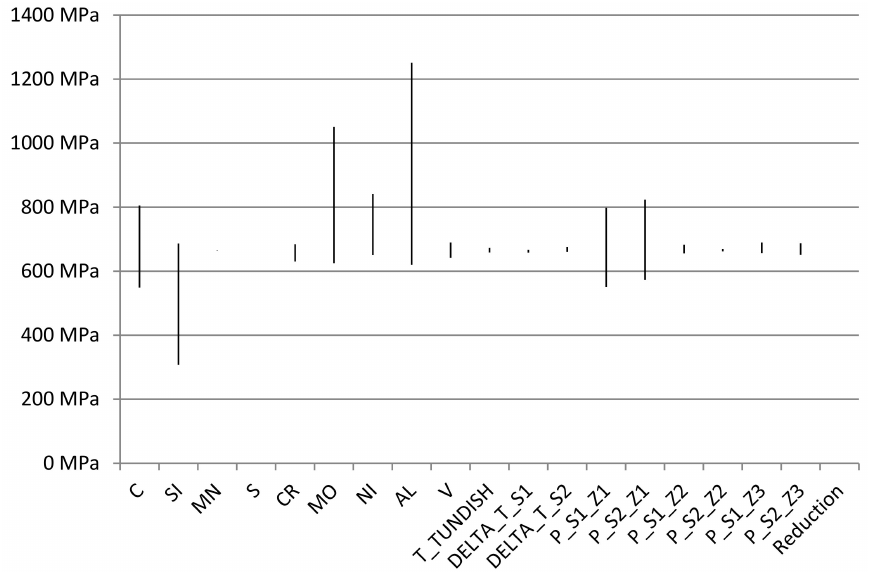
Figure 2. Calculated influences of individual parameters on tensile strength using the Genetic Programming